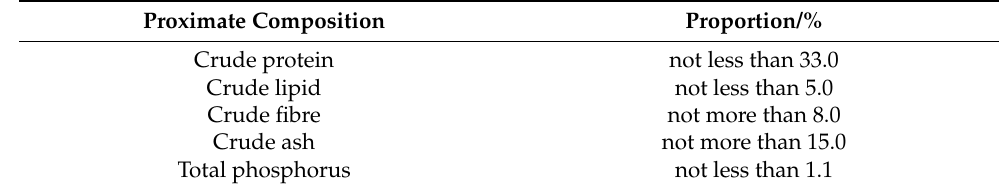
Table A1. Proximate composition of No.2 diet used in the